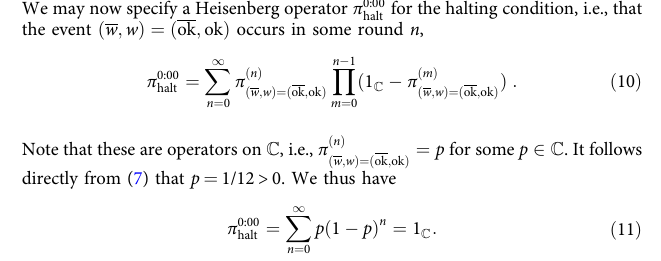
Time evolution of F ’ s lab L